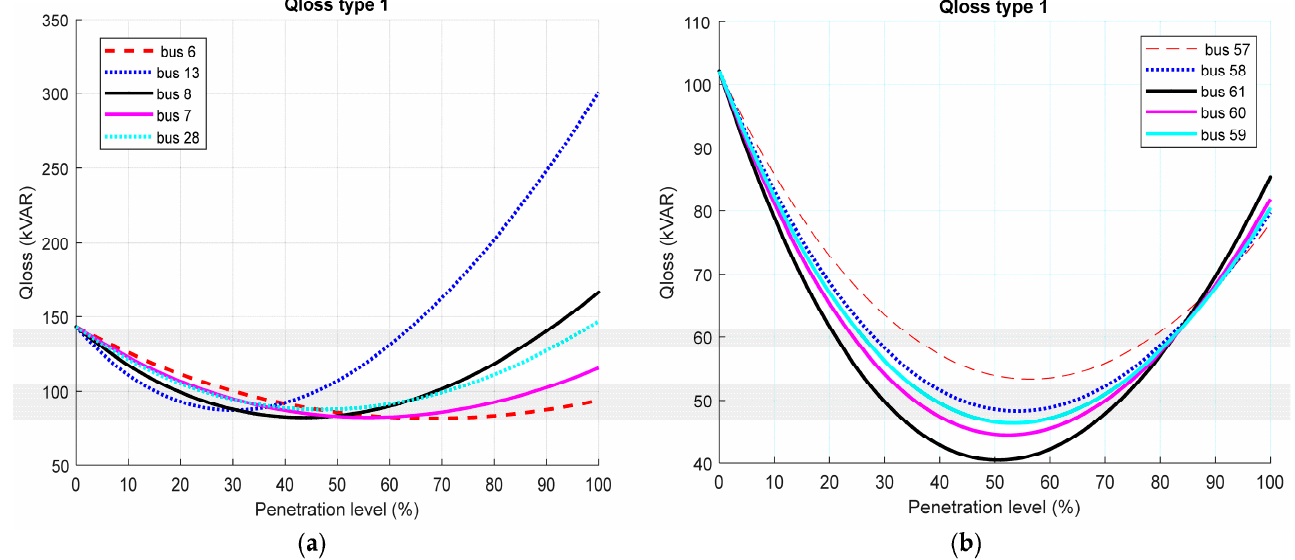
Figure 14. Reactive power loss when Type 1 DG was interconnected to selected nodes of IEEE ( a ) 33-bus ( b ) 69-bus RDNs.